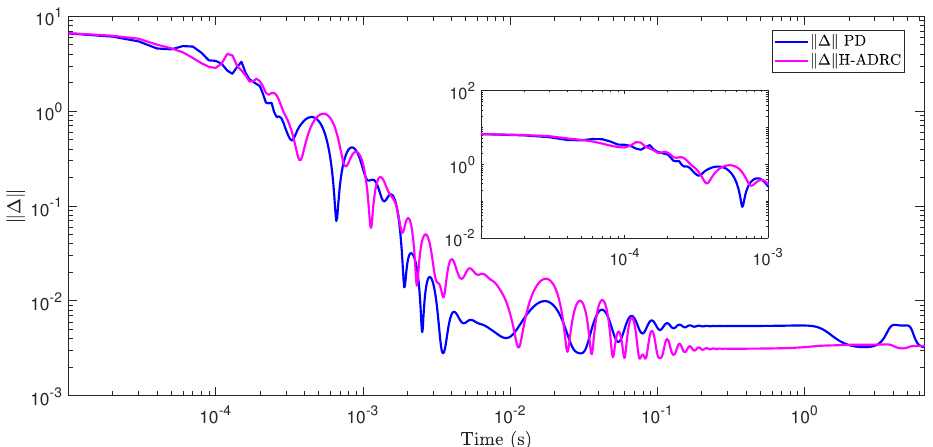
Figure 9. Euclidean norm of the tracking error for each control technique used in